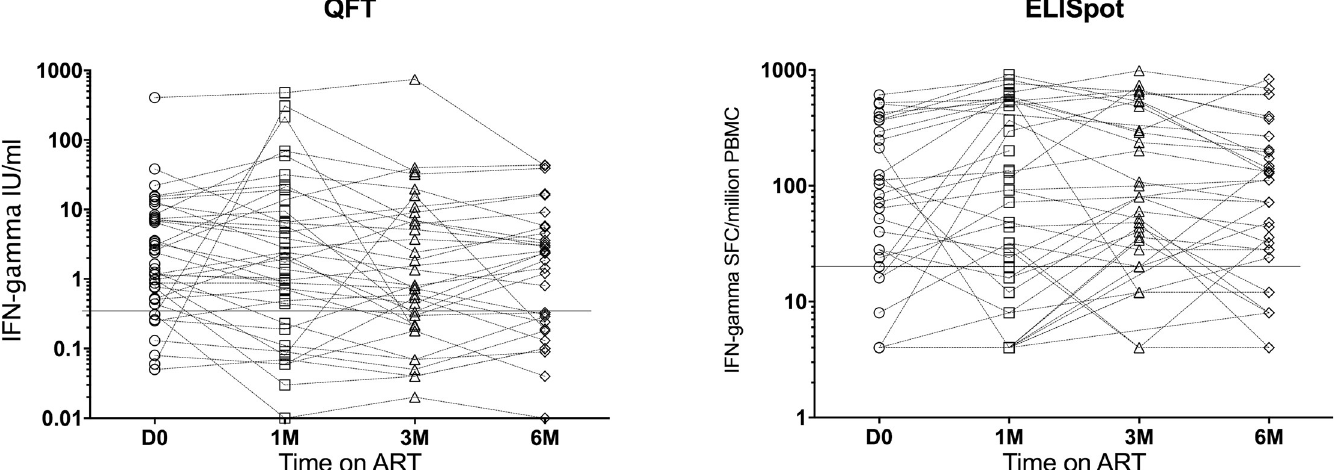
Fig 2. MTB sensitisation of the patients as determined by interferon gamma release assays QFT-gold in-tube (cutoff 0.35 IU/ml) and in house ELISpot (cut-off 20 spot forming cells per million PBMC). All patients were positive in at least one assay, at least one timepoint during the longitudinal follow up.